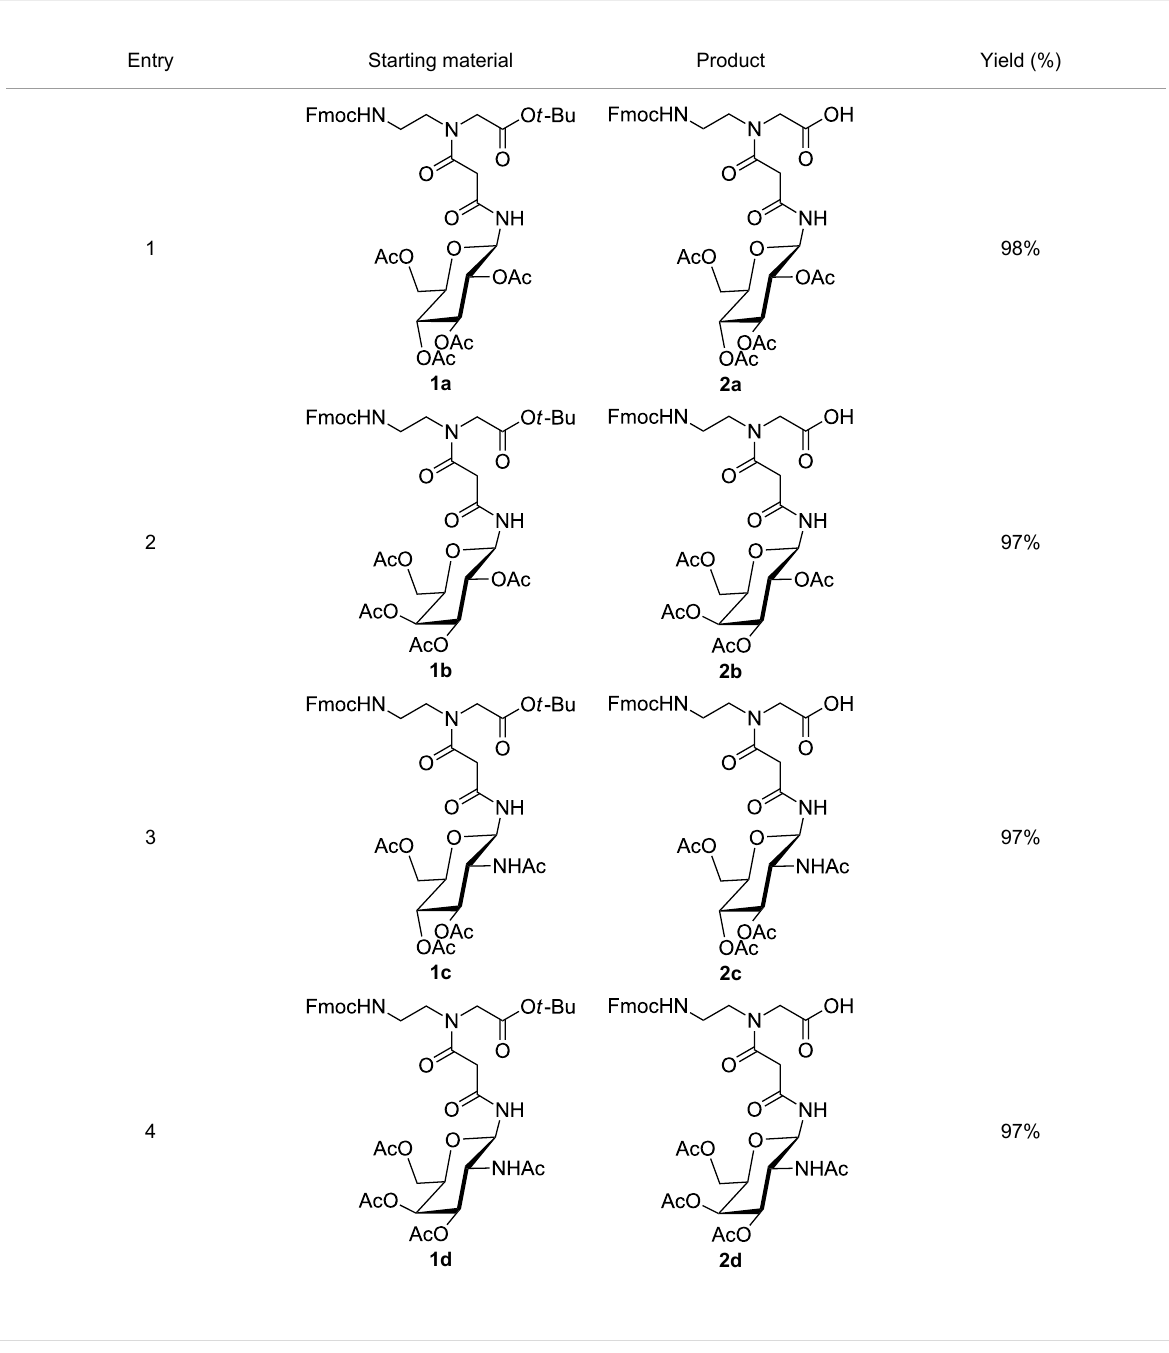
Table 2: Synthesis of building blocks 2a–d